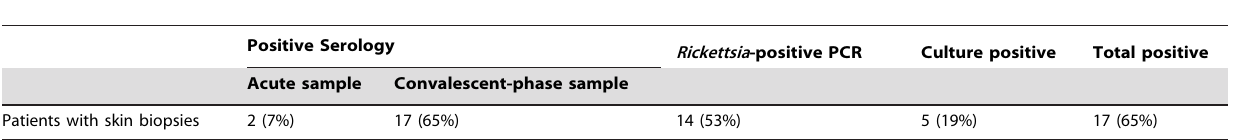
Table 3. Results for the 26 patients with suspected rickettsiosis who had an acute and a convalescent-phase serum sample.